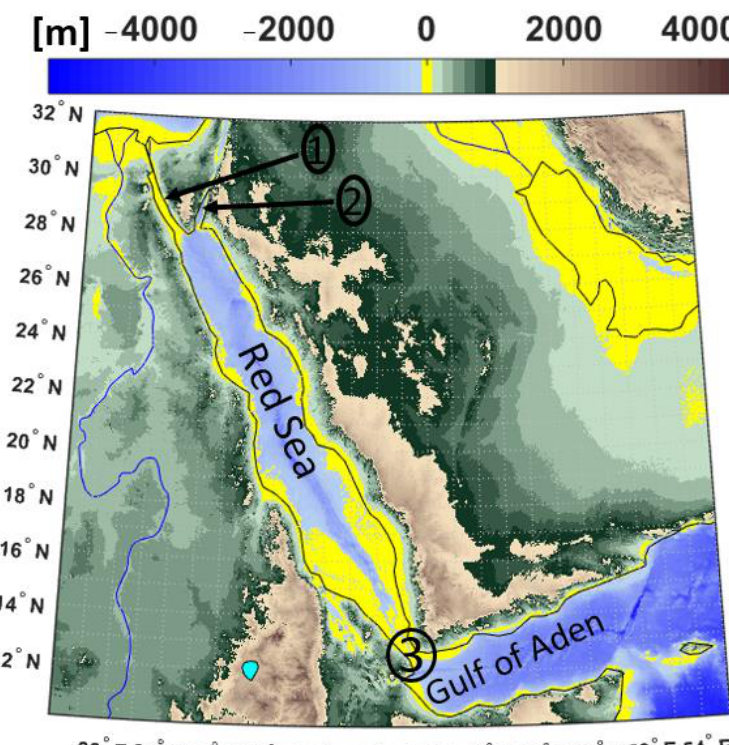
Figure 1. Digital elevation data of the Red Sea (data acquired from a global 30 arc-second interval grid (GEBCO: https://www.gebco.net/data_and_products/gridded_bathymetry_data/ [accessed on 10 May 2021]). The Gulfs of Suez (1), and Aqaba (2) together with the strait of Bab al Mandab were shown in the figure.